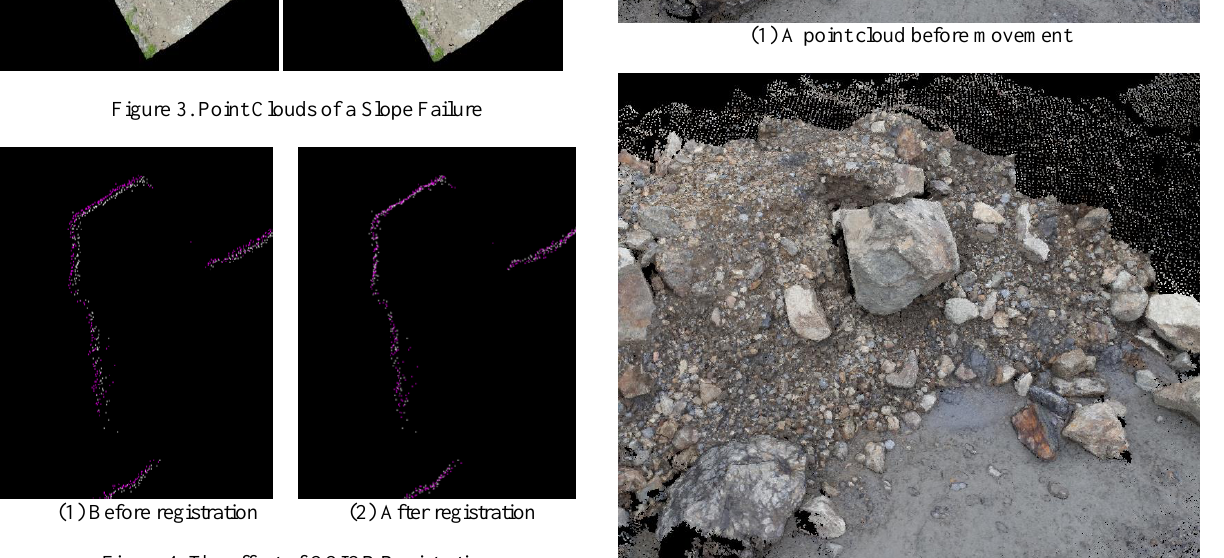
Figure 4. The effect of CCICP Registration